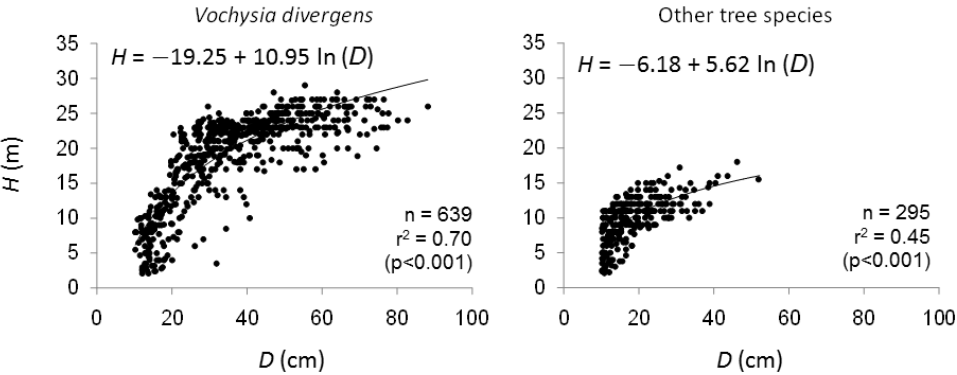
Fig. 2. Non-linear relationships between diameter at breast height, D , and tree height, H , from Vochysia divergens and other tree species from northern Pantanal wetland